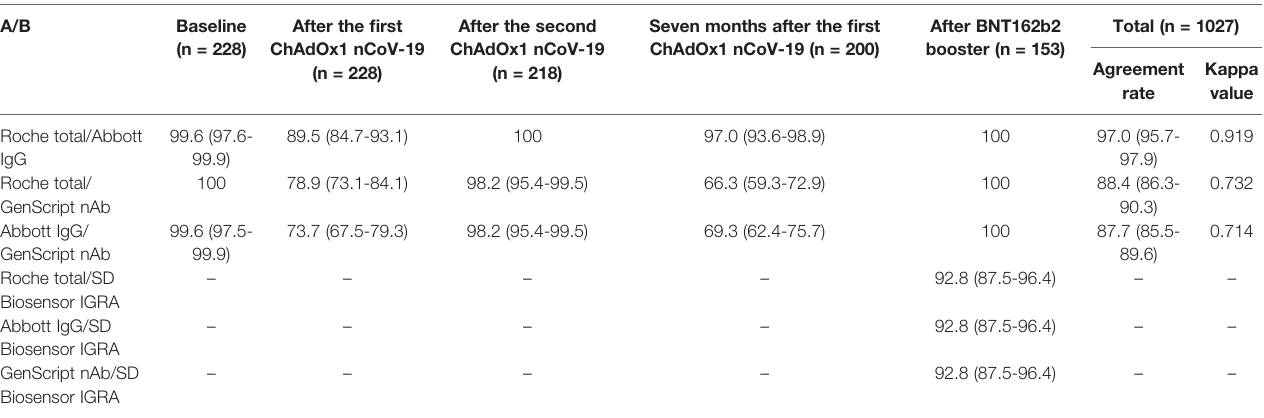
TABLE 3 | Agreement rates among four SARS-CoV-2 assays a